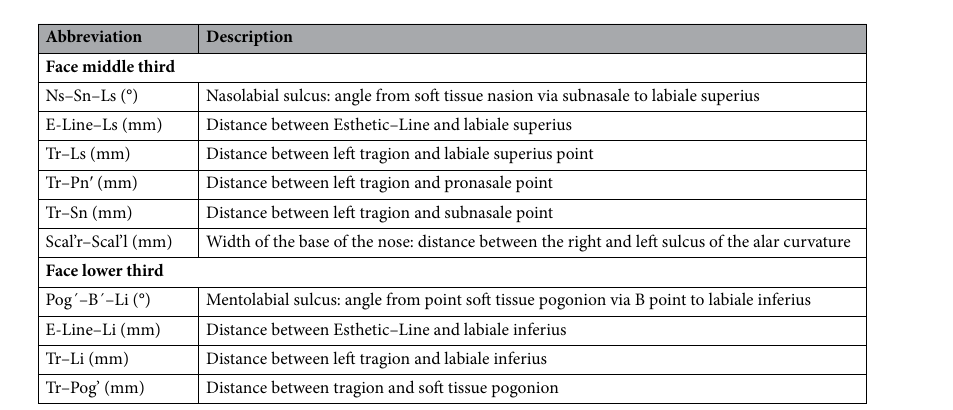
Table 3. Angular and linear measurements of the middle and lower third of the